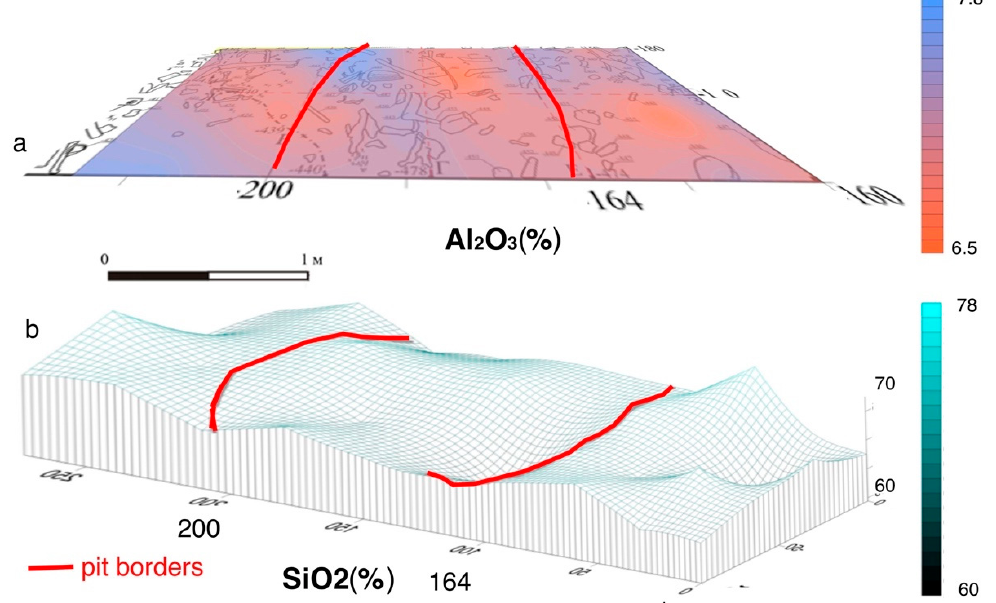
Figure 14. The Yudinovo site. Geochemical maps of ( a ) Al 2 O 3 ( b ) 3D distribution of SiO 2 in the sediments [44], designed by M.Kulkova.